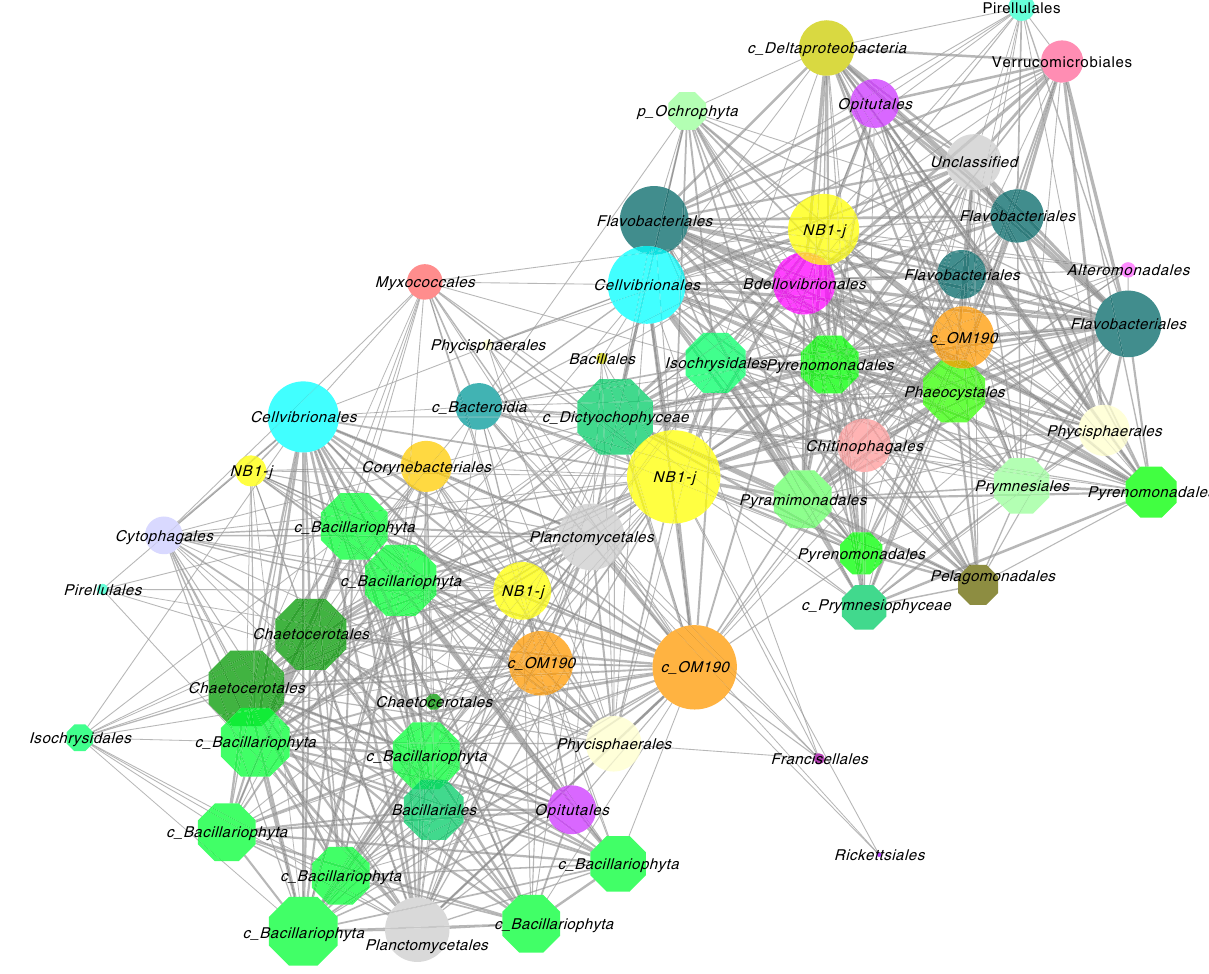
Figure 3. Interactions of the Deltaproteobacterial order NB1-j with microalgae in a marine environment. Figure shows the first neighbours (directly interacting taxa) including microalgal taxa co-occurring with Deltaproteobacterial order NB1-j . Nodes are labelled at the order level (If unclassified at the order level, higher taxonomic affiliations are provided). The edge width and node size are continuously mapped to edge weight (correlation strength) and node degree, respectively. Network image was generated using Cytoscape v3.8 (https:// cytos cape.